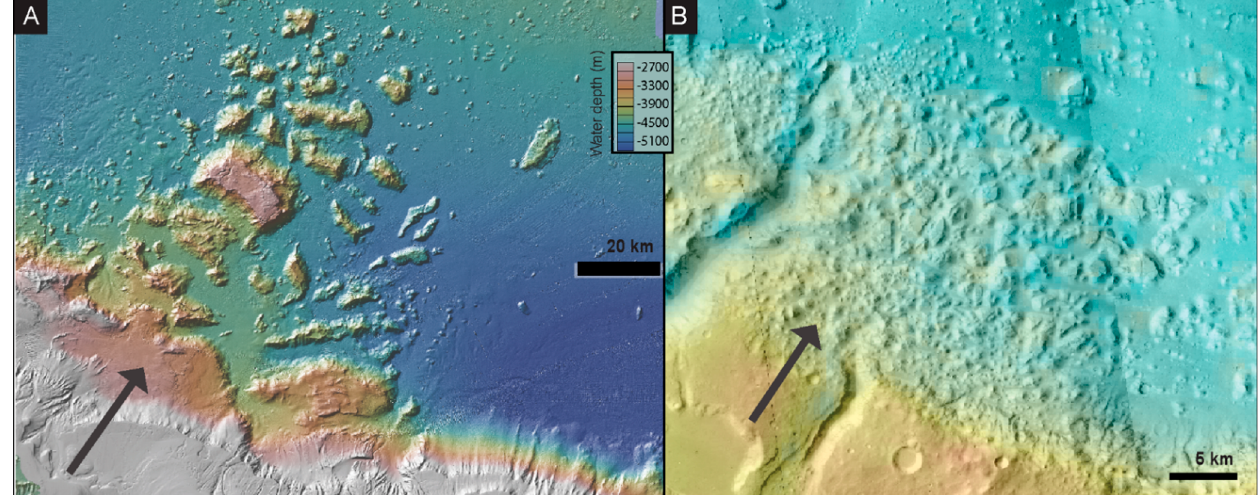
Figure 9. Subaqueous mass flow Earth analog. Black arrows in this figure illustrate the direction of the slide from the region of interpreted slope failure toward the transport direction and deposit. ( A ) Subaqueous landslide analog from Nuuanu and Wailau landslide on the west coast of Oahu, Hawaii. As with Galilaei crater, the deposit is composed of disorganized blocks, the largest of which are flat-topped, and the blocks qualitatively decrease in size in the transport direction. Image from the generic mapping tool [57]. ( B ) Chaotic terrain in Galilaei crater interpreted to have originated from subaqueous landslides (as in ( A )).